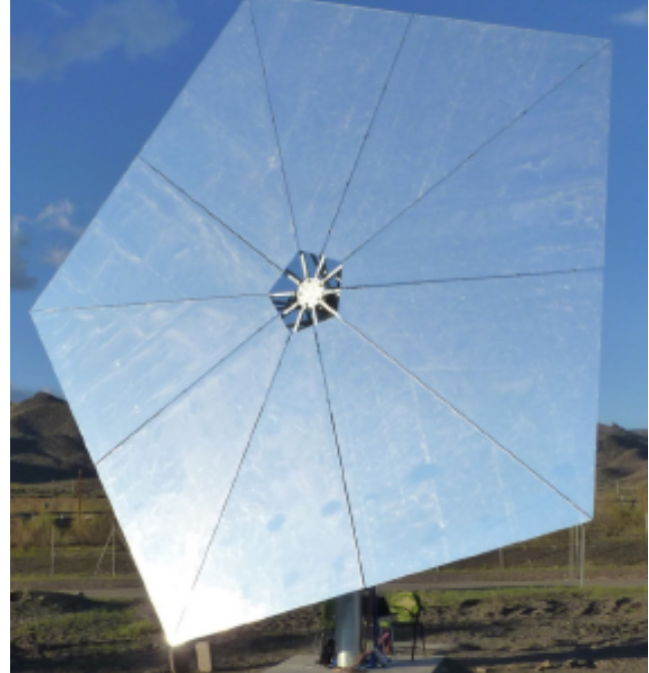
Fig. 2. Heliostat development ‘Stellio’.